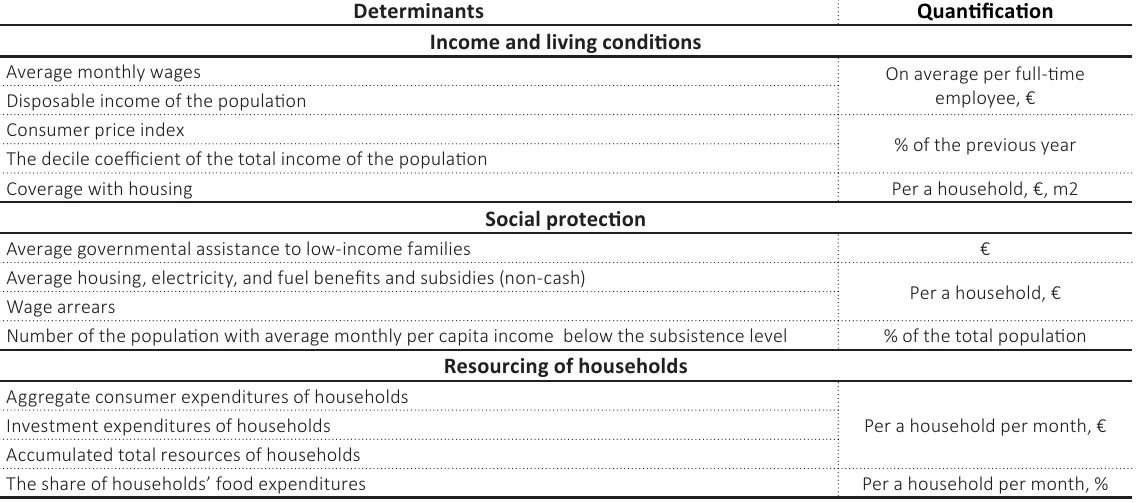
Table 1. The system of determinants of the households’ financial wellbeing in an unstable economy